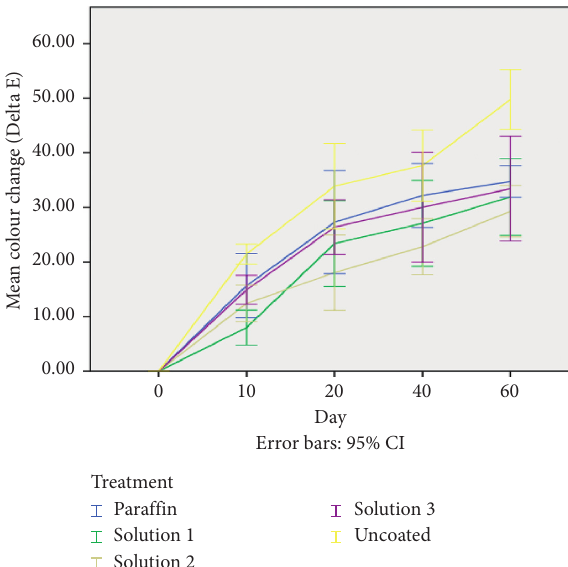
Figure 13: Values (means ± SD) of the color change of cheese coated with antimicrobial edible coating solutions—solution 1 (0.250 g/L Delvocid), solution 2 (0.275g/L Delvocid), and solution 3 (0.300g/L Delvocid)—compared with cheese coated with com- mercial coating and uncoated cheese throughout 60d of storage at 10 ° C and 85% relative humidity.